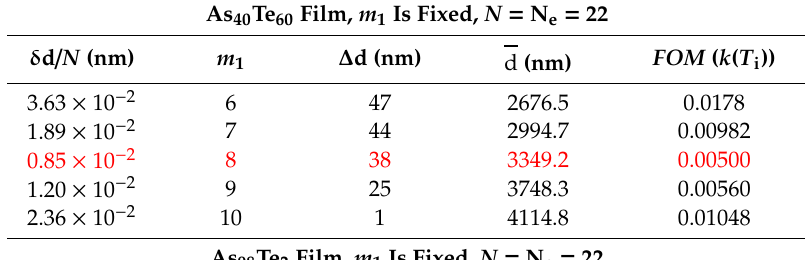
Table 1. The main results from the characterizations of the three As x Te 100–x films by the simplified AOEM with fixed values of m 1 and N = N e . The data corresponding to the smallest FOM ( k ( T i )) are in red color and the data regarding the smallest δ d / N are in blue if they refer to di ff erent m 1 .